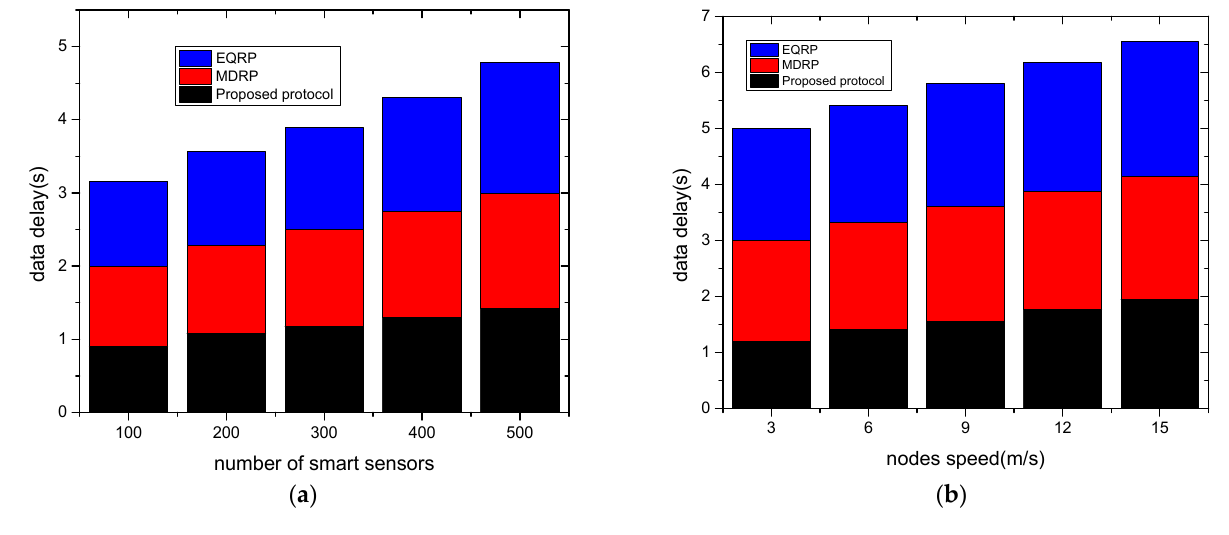
Figure 6. Varying smart sensors and nodes speed in terms of data delay. ( a ) Data delay and varying sensors; ( b ) data delay and varying node speed.